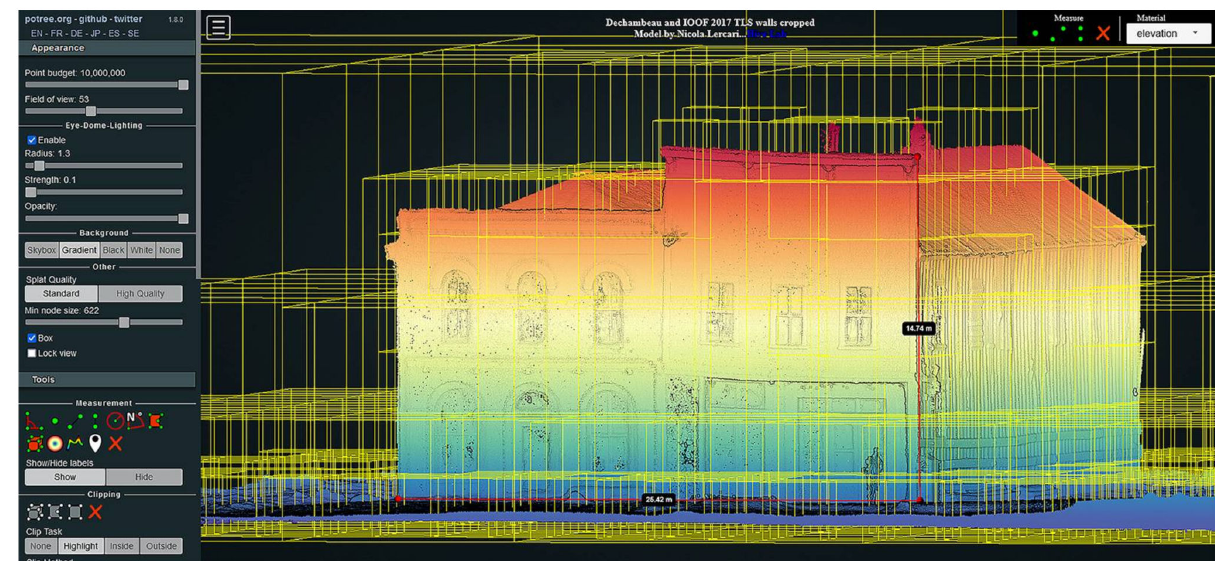
Figure 9. View of the Dechambeau and IOOF Hall buildings’ 2016 point cloud visualized in our instance of the Potree Viewer showing elevation (point cloud color coding), measurements (red lines), and octrees (yellow cubes). Visualization by S.